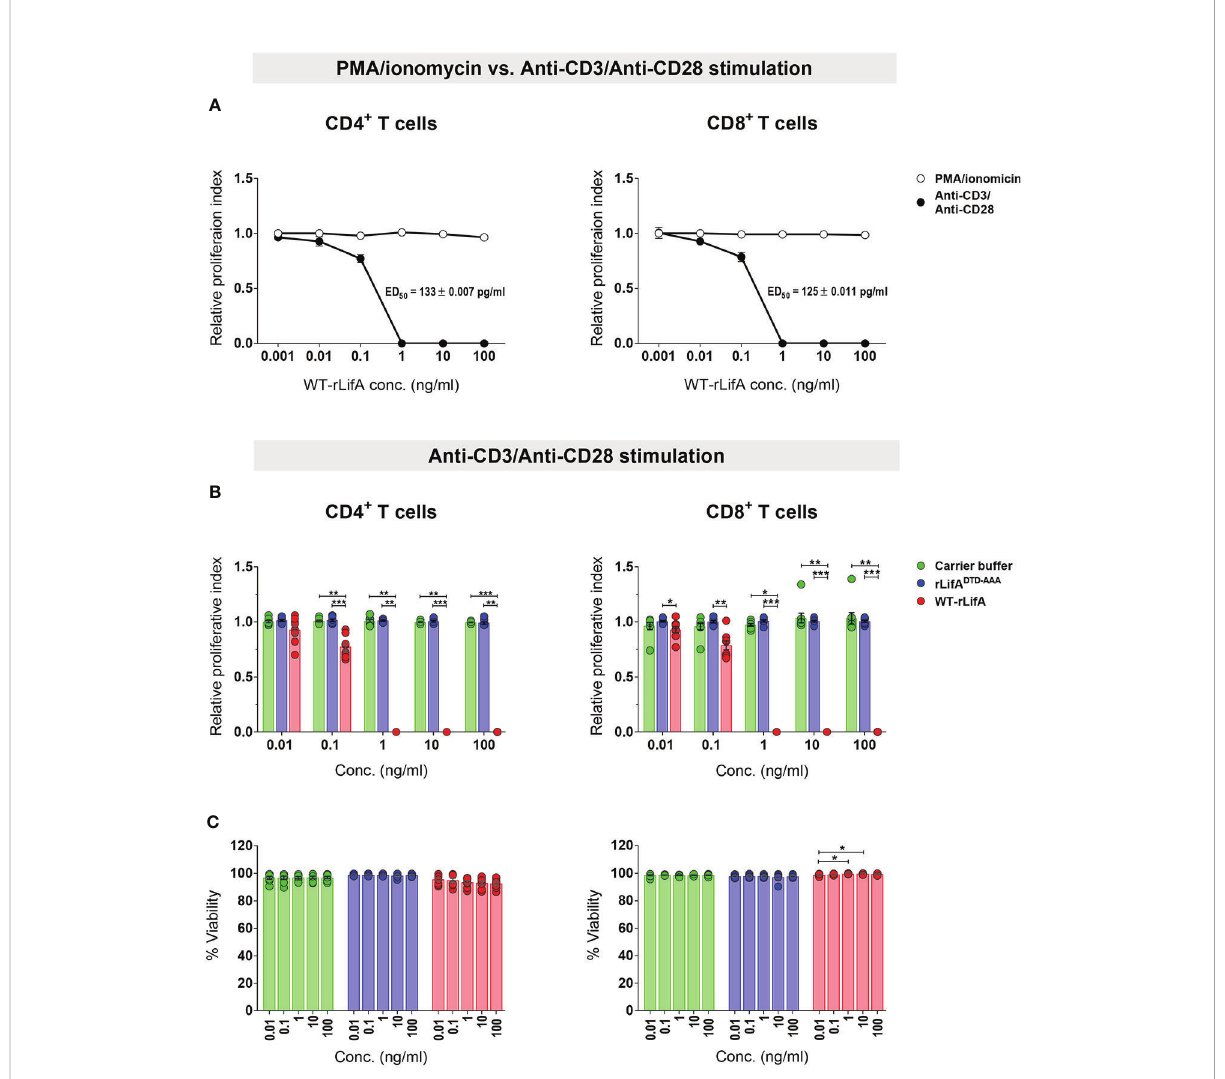
FIGURE 2 Lymphostatin inhibits proliferation of human CD4 + and CD8 + T cells without affecting viability. (A) Relative proliferation index of CD4 + and CD8 + T cells treated with varied WT-rLifA concentrations was compared between stimulation with anti-CD3/anti-CD28 mAbs versus PMA/ ionomycin. The ED 50 of WT-rLifA against CD4 + and CD8 + T cells treated with WT-rLifA is shown. (B) Relative proliferation index of anti-CD3/ anti- CD28-stimulated CD4 + and CD8 + T cells in the presence of WT-rLifA, rLifA DTD-AAA , or carrier buffer. (C) Viability of anti-CD3/anti-CD28- stimulated CD4 + and CD8 + T cells in the presence of WT-rLifA, rLifA DTD-AAA , or carrier buffer. Data represent the mean from 8 healthy donors ± S.E.M. * p < 0.05, ** p < 0.01, *** p < 0.001 using Kruskal-Wallis test followed by Dunn ’ s test. Symbols with circles in Figures 2B, C represent data from the individual